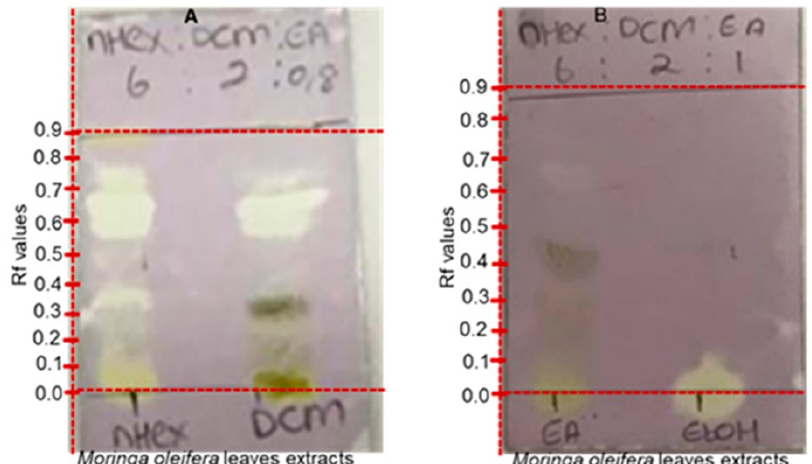
Figure 7. Developed TLC plates of hexane, dichloromethane extracts ( A ), and ethyl acetate and ethanol extracts ( B ). Plates were stained with 10% DPPH solution and visualized under visible light.